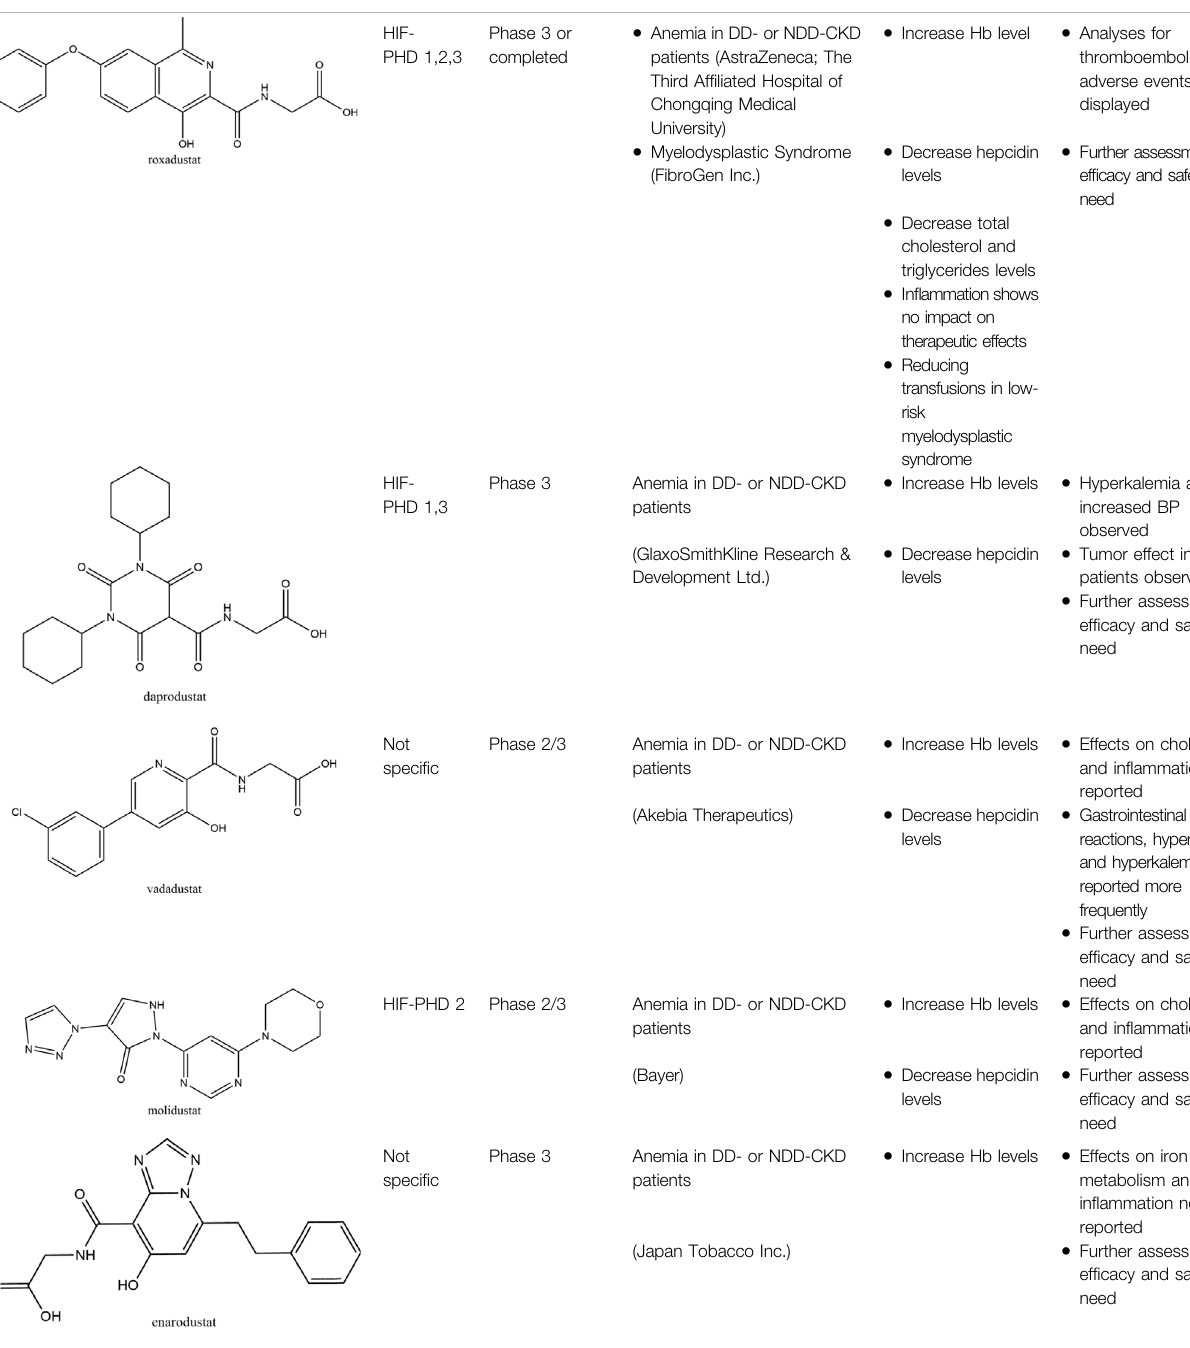
TABLE 1 | Molecular character, mechanisms of action, development status and main limitation of fi ve clinical available HIF-PHIs.